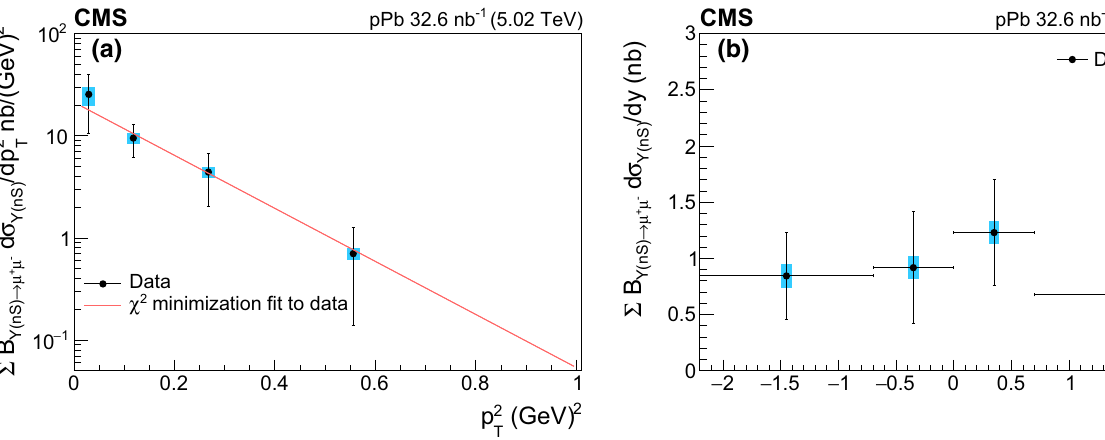
Fig. 4 Differential ϒ( nS ) → μ + μ − photoproduction cross section as a function of a p 2 and b rapidity y , measured in pPb collisions at √ T = 5 . 02TeV. In the left plot, the data points are placed along s NN the abscissa following the prescription of [62], and the solid line is an